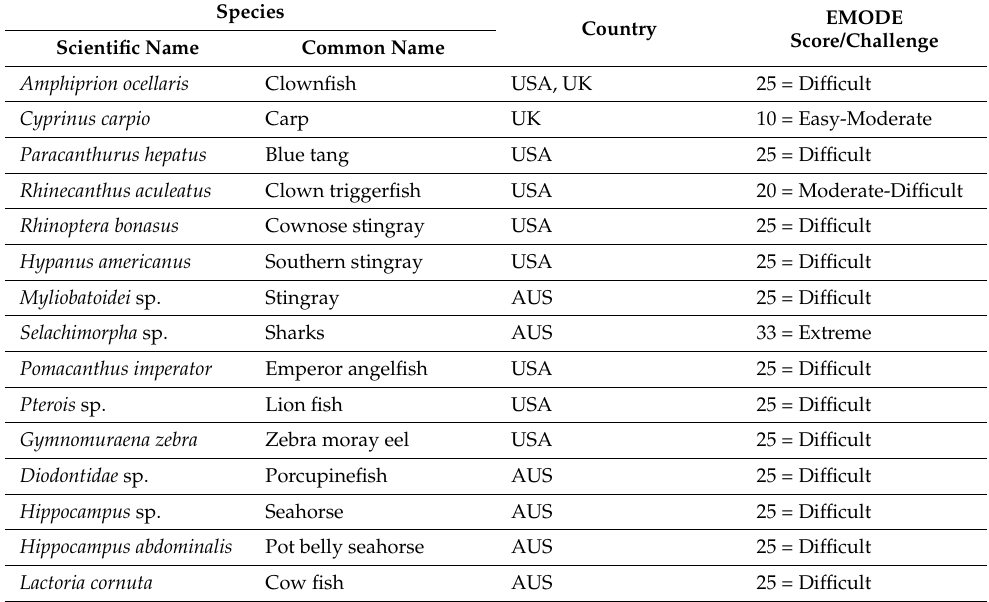
Table 4. Fishes involved in handling and other practices at mobile zoos by species and country of where used, and their EMODE * ‘suitability to keep’ scores.